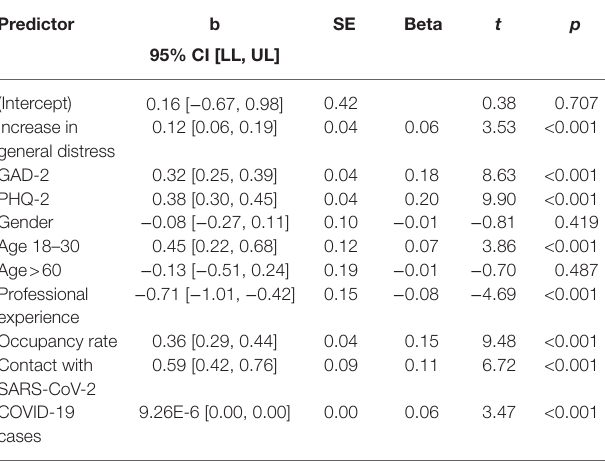
TABLE 4 | Summary of multiple regression analysis for the total sample ( N = 3,293) using moral distress as the criterion.